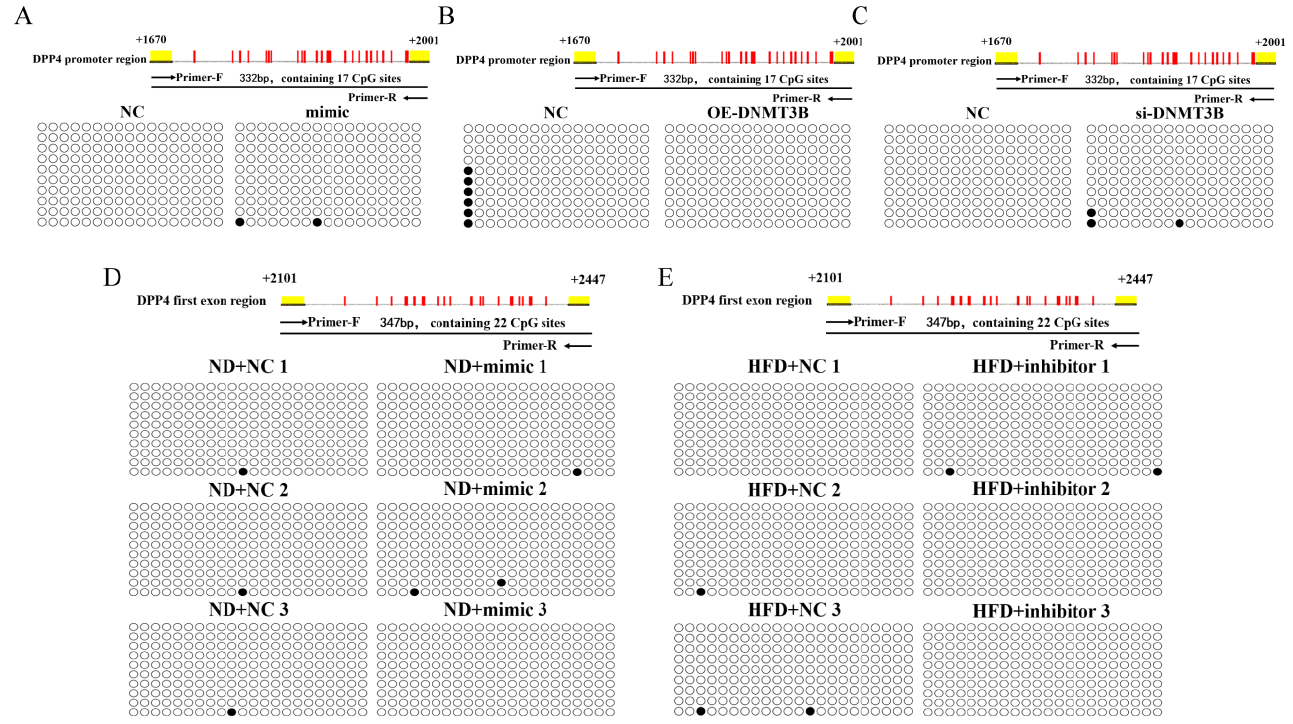
Figure 7. The BSP experiment. ( A ) Schematic diagram of the methylation status of the CpG sites in the promoter region of the DPP4 gene. HepG2 cells were transfected with 50 nM miR-548ag mimic for 24 h after the upregulation of miR-548ag. ( B , C ) The schematic diagrams of the methylation status of the CpG sites in the promoter region of the DPP4 gene. The transfection of 4 µg/mL of the DNMT3B-overexpression plasmid and 40 nM of the DNMT3B interference fragment into HepG2 cells was performed for 24 h after the up/down-regulation of DNMT3B. ( D ) The methylation status of the CpG sites in the promoter region of the mouse liver DPP4 gene. Adenovirus particles encoding the miR-548ag mimic were injected intraperitoneally into the normal diet-fed mice for 6 weeks. ( E ) Schematic diagram of the methylation status of the CpG sites in the promoter region of the mouse liver DPP4 gene. Adenovirus particles with the miR-548ag inhibitor were injected intraperitoneally into the HFD-induced obese mice for 6 weeks. ○ represents the non-methylated CpG site; ● represents the methylated CpG site.